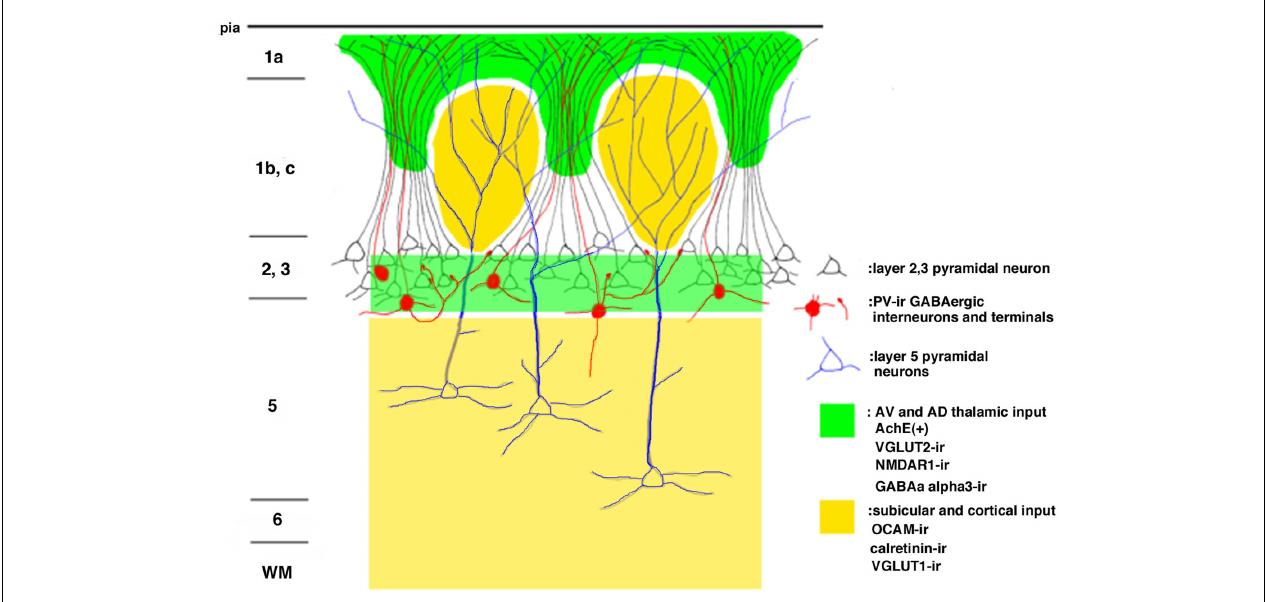
FIGURE 1 | Schematic drawing of the modular organization of the layer 1 granular retrosplenial cortex (GRS). Arabic numbers represent layer numbers. ir, immunoreactive.